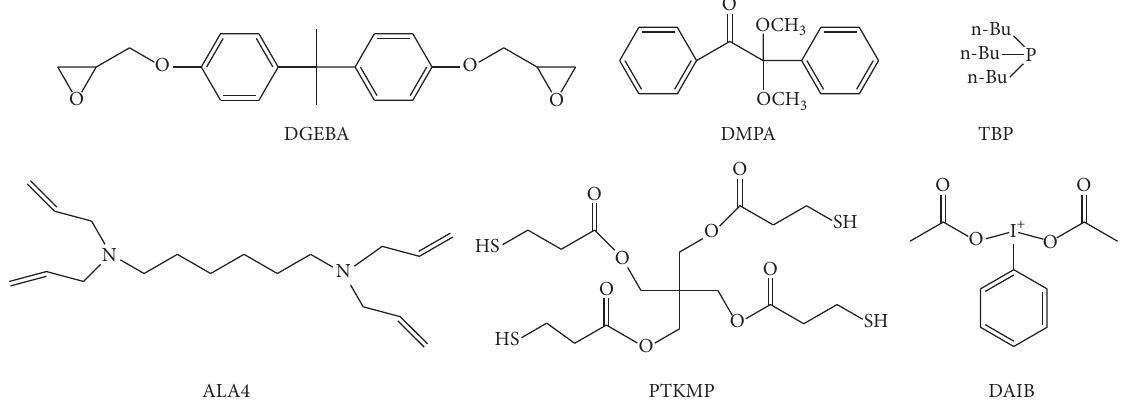
Scheme 1: Chemical structure of the compounds used in this